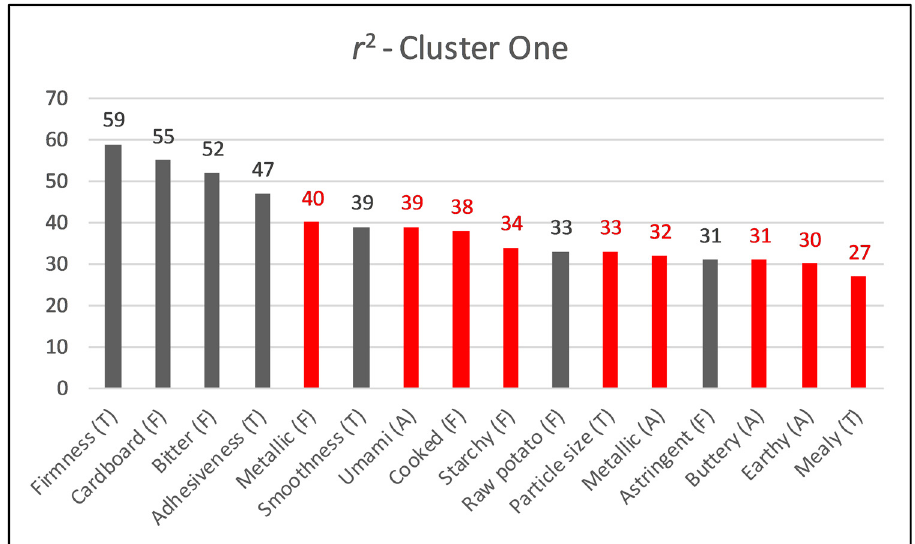
Figure 2. Internal Preference Mapping (IPM) plot for the first segment of respondents ( N = 46); Magenta colored markers ■ and labels—Samples; gray colored markers ▲ and labels—sensory descriptors; red colored markers ● and vectors—participants/consumers. IPM plots were obtained by using PCA technique on covariance. All sensory descriptors were added as supplementary variables. Homogeneous respondents were pre-identified by using Hierarchical clustering.